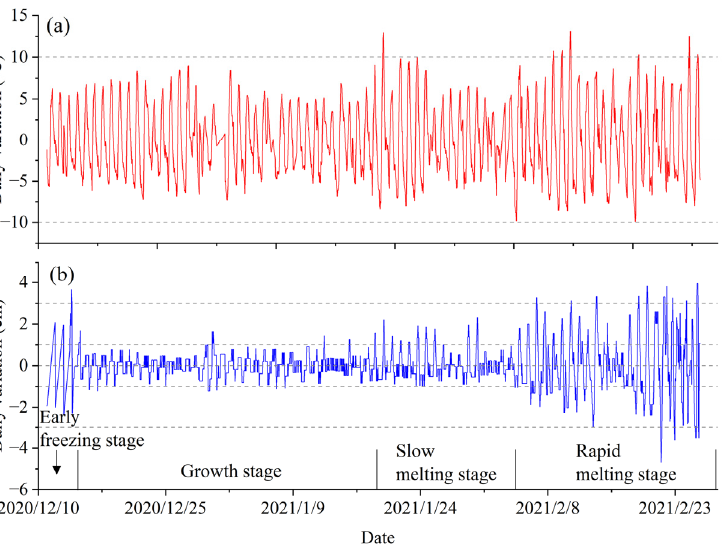
Figure 5. Daily variation for ( a ) air temperature and ( b ) radar-detected ice thickness at the Shisifenzi bend.